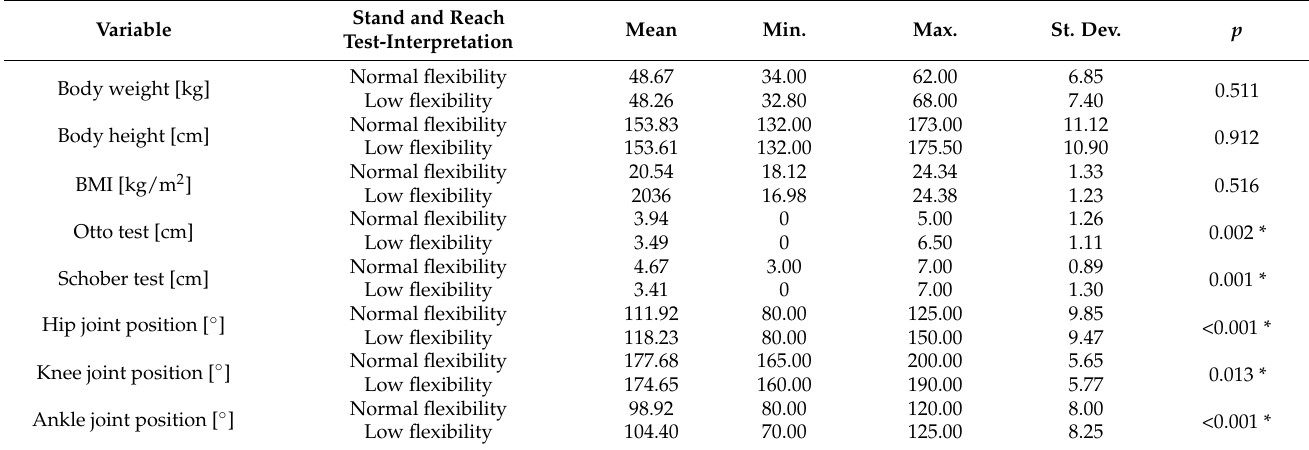
Table 5. Variable values based on good or poor